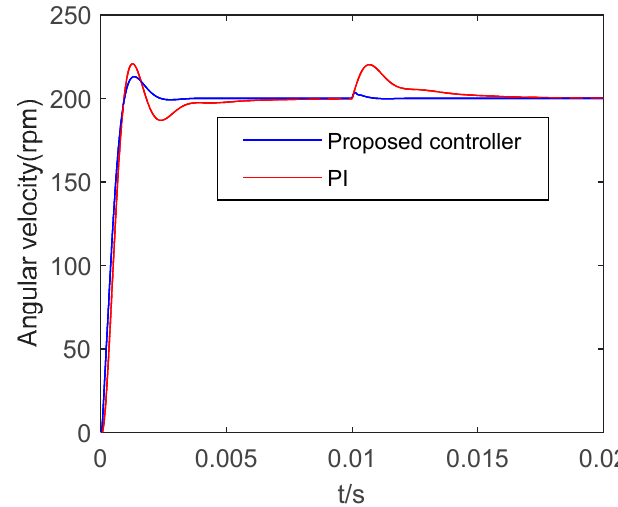
Figure 16. Step response with disturbance.